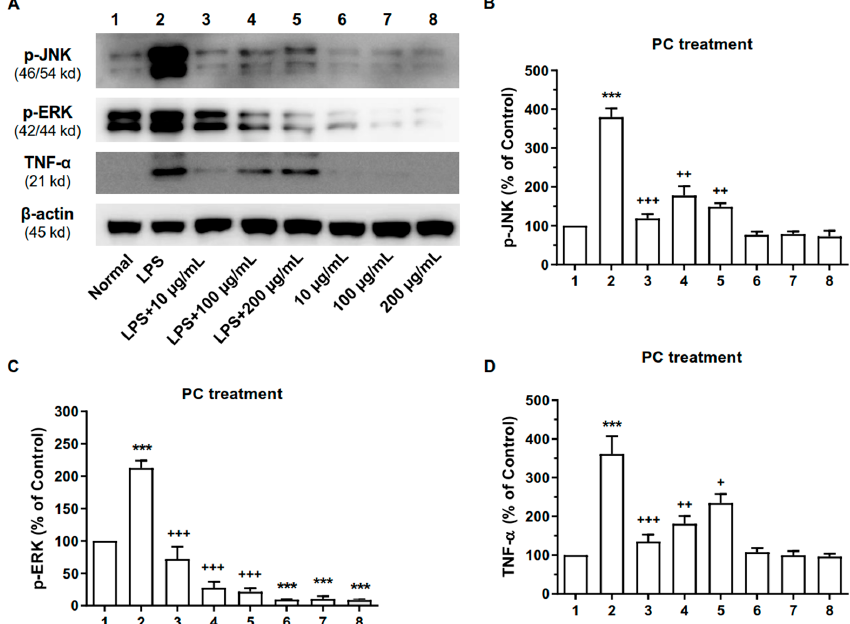
Figure 7. Effect of PC on p-JNK, p-ERK, and TNF- α proteins in RAW 264.7 cells. ( A ) The expression levels of TNF- α , p-ERK, and p-JNK proteins were measured by performing Western blotting analysis. The Raw 264.7 cells were treated with PC for 24 h. 1—Normal group, 2—LPS-treated control group, 3—LPS-treated control group + 10 µ g/mL PC, 4—LPS-treated control group + 100 µ g/mL PC, 5—LPS-treated control group + 200 µ g/mL PC, 6—Normal group + 10 µ g/mL PC, 7—Normal group + 100 µ g/mL PC, 8—Normal group + 200 µ g/mL PC. Quantitative analysis of the results of the Western blotting analysis are shown in ( B ) for p-JNK, in ( C ) for p-ERK, and in ( D ) for TNF- α proteins. β -Actin was used as an internal control. Values are mean ± SEM ( n = 3). These values are expressed as the percentage of the control tested protein/ β -actin for each sample. p-JNK ( B ): 1 vs. 2 p < 0.0001, 2 vs. 3 p = 0.0001, 2 vs. 4 p = 0.0014, 2 vs. 5 p < 0.0146; p-ERK ( C ): 1 vs. 2 p = 0.0001, 2 vs. 3 p = 0.0002, 2 vs. 4 p < 0.0001, 2 vs. 5 p < 0.0001, 1 vs. 6 p < 0.0001, 1 vs. 7 p < 0.0001, 1 vs. 8 p < 0.0001; TNF- α ( D ): 1 vs. 2 p = 0.0006, 2 vs. 3 p = 0.0004, 2 vs. 4 p = 0.0057, 2 vs. 5 p = 0.0066. (one-way ANOVA for multiple comparisons, ** p < 0.01, *** p < 0.001; + p < 0.05, ++ p < 0.01, +++ p <